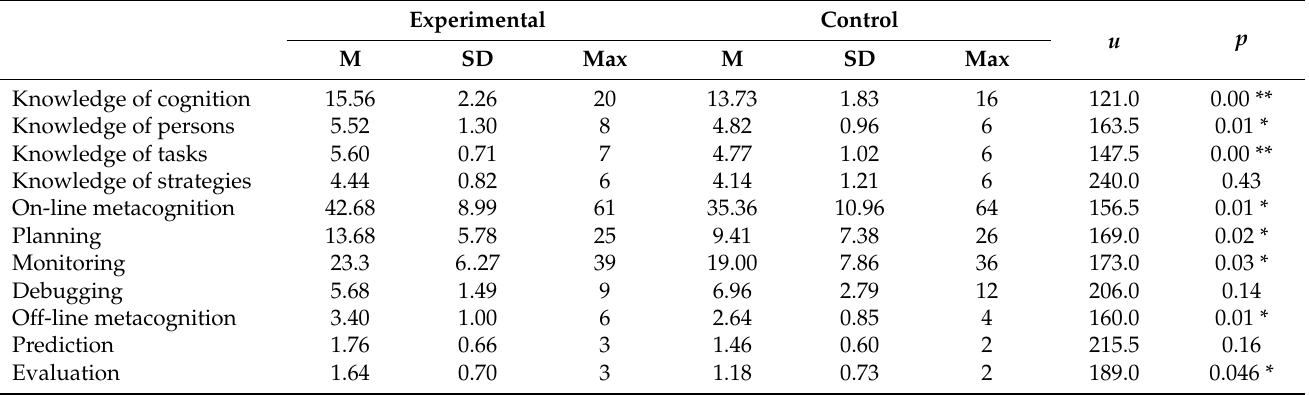
Table 4. The means, standard deviations, and maximum of the metacognition scores and Mann– Whitney test results in the